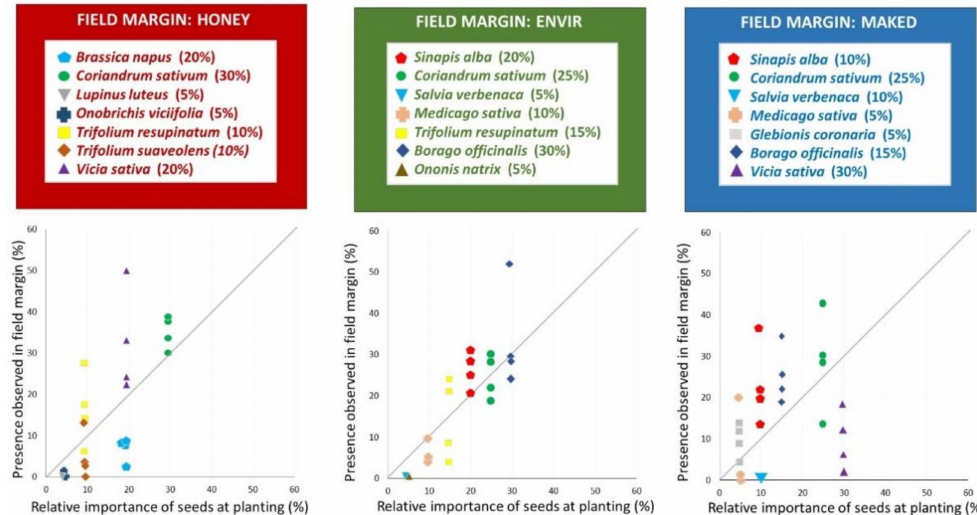
Figure 2. Sowing and appearance percentages in sown MFM. Diagonal line is 1:1 ratio.